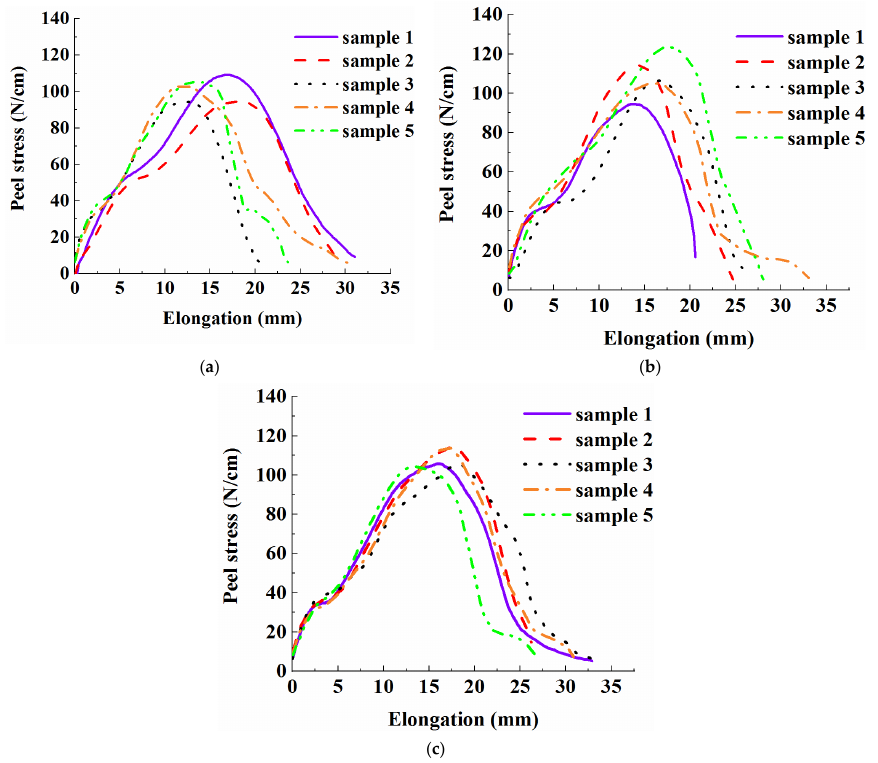
Figure 13. Peel stress–elongation relationship of the junction subjected to a peeling force under various clamping distances: ( a ) 25 mm, ( b ) 50 mm, ( c ) 100 mm.